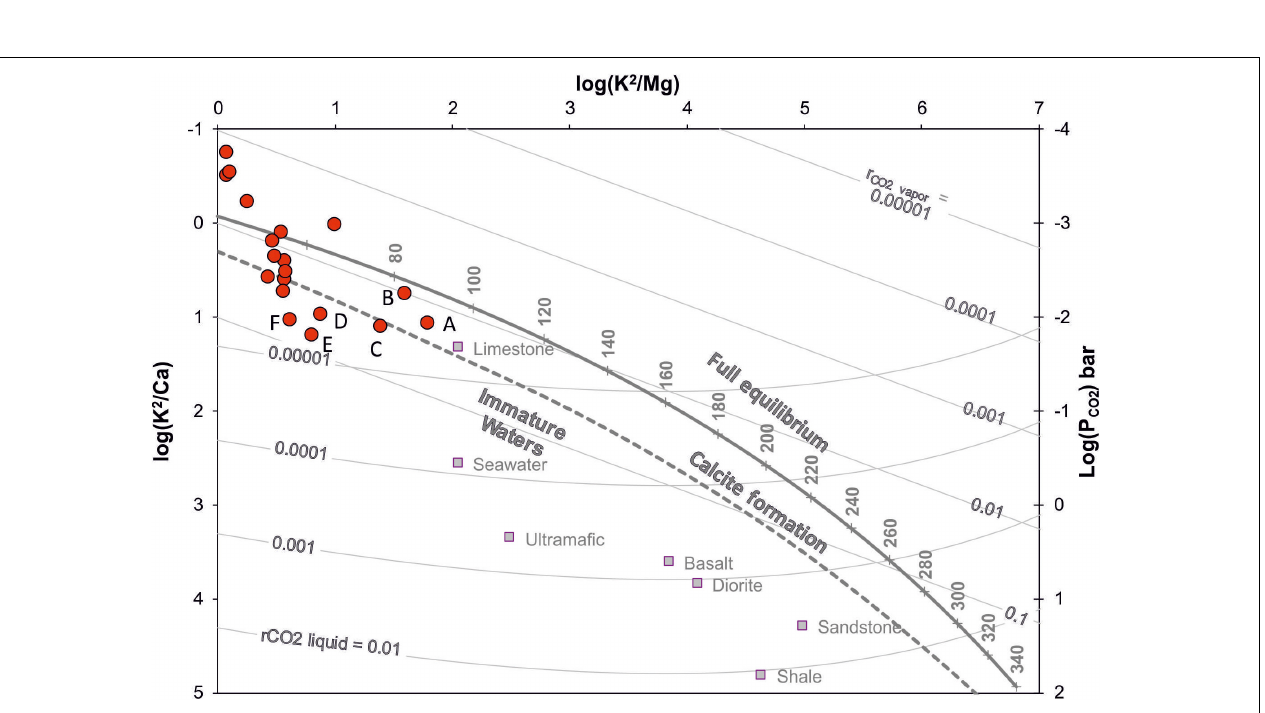
Frontiers in Earth Science |